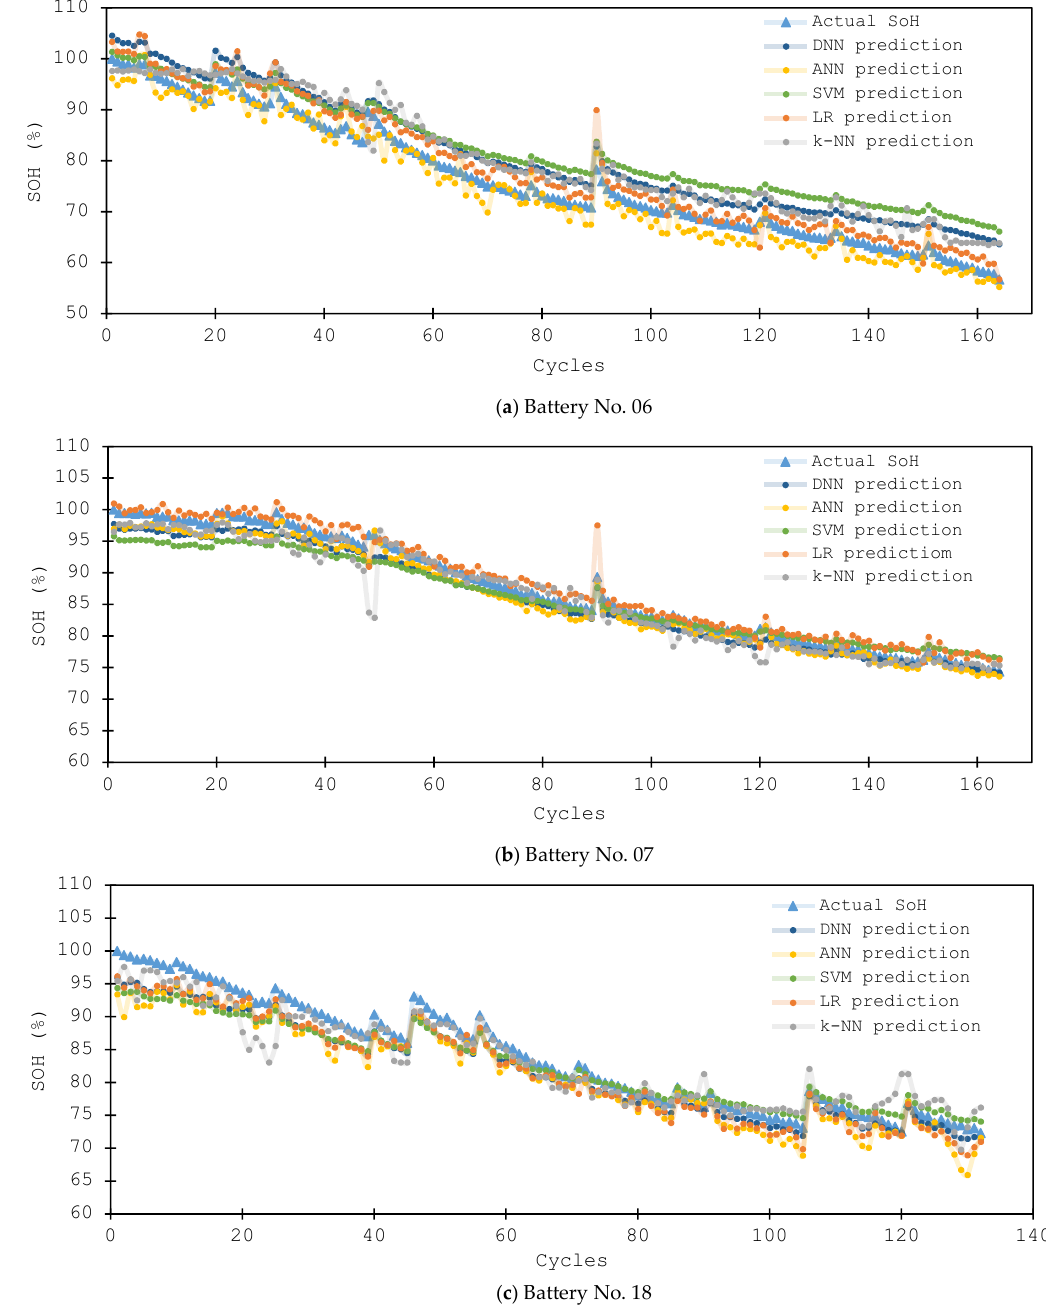
Figure 7. The SoH estimation with all algorithms for battery No. ( a ) 06, ( b ) 07, and ( c ) 18.